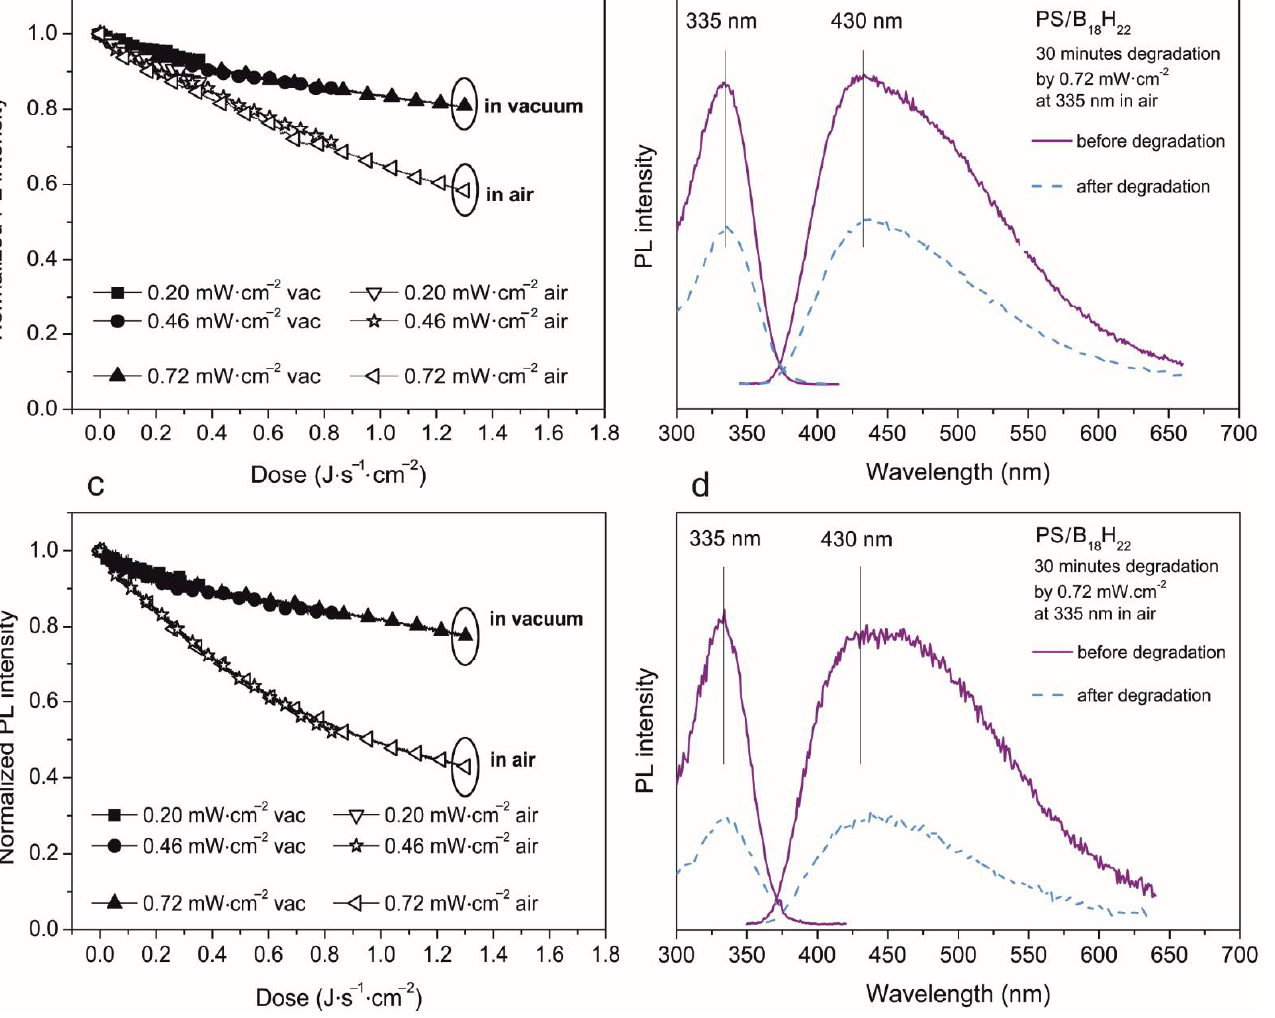
Figure 6. Photodegradation study of 750 nm ( a , b ) and 200 nm ( c , d ) thick film of PS/ anti -B 18 H 22 in ratio 9:1. Left ( a , c )— evolution of normalized PL intensity of emission maxima in both vacuum and air environment depending on the energy dose. The excitation and emission spectra measured before and after 30 min of degradation—right ( b , d ).